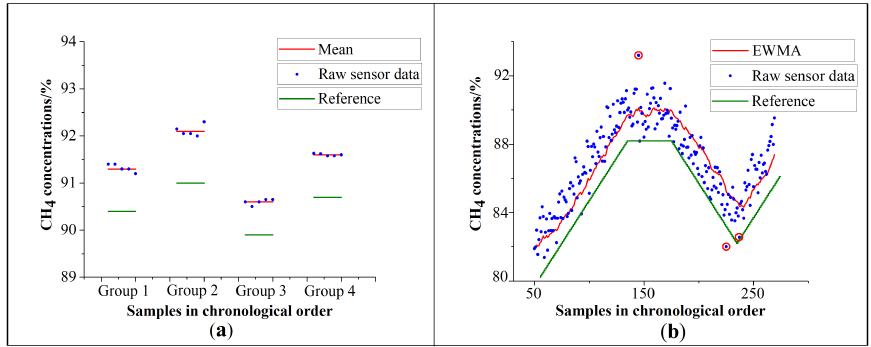
Figure 3. ( a ) Data processed by average method. ( b ) Data processed by EWMA.